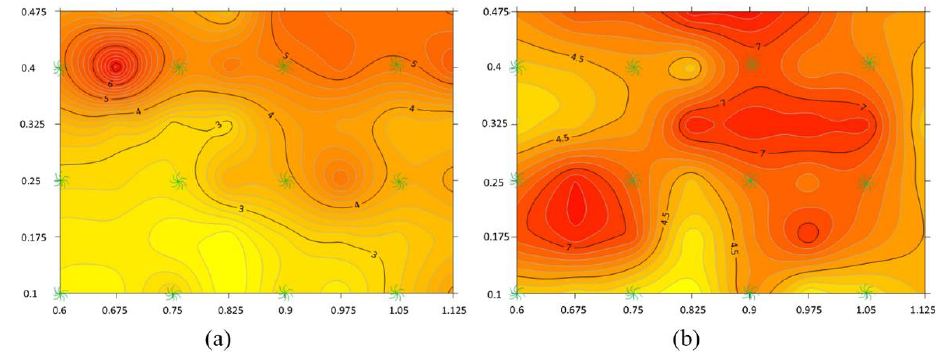
Figure 13. Contour of Turbulence Kinetic Energy (TKE) for deflected vegetation case having a square configuration ( λ = 0.04, water depth = 30 cm): ( a ) around the top of vegetation z/H = 0.4l; ( b ) near the bed z/H = 0.